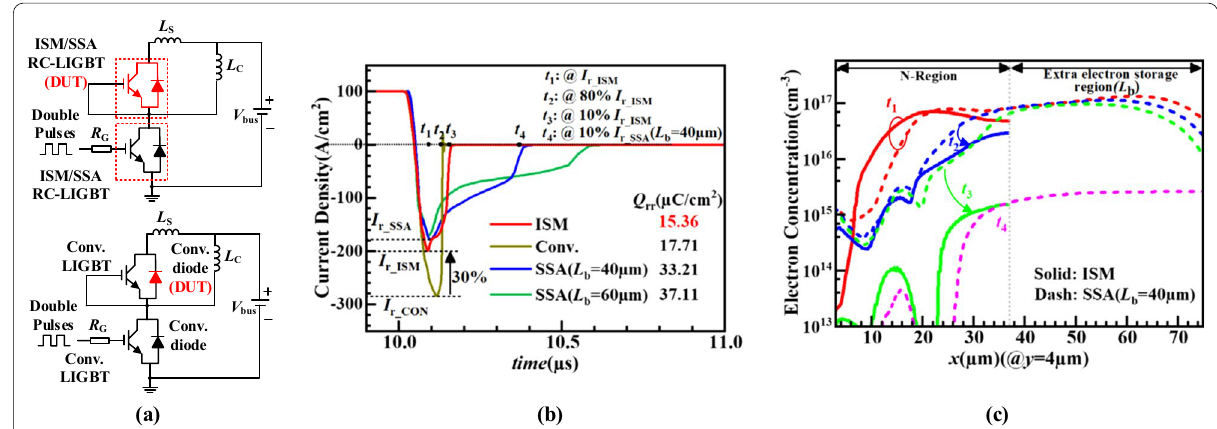
Fig. 10 Reverse recovery characteristics of the ISM RC-LIGBT, SSA LIGBT and the conventional LIGBT with an anti-parallel diode: a circuit diagram for reverse recovery ( L C